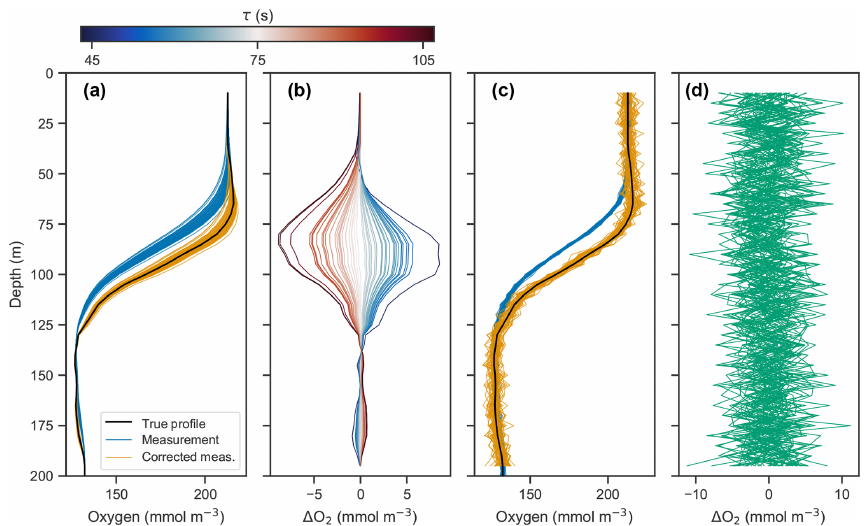
Figure 3. (a) Simulated profile measurements (blue) of the true oxygen profile (black) for 50 different response times drawn randomly from a normal distribution with a standard deviation of 15s and mean of 75s, and corrected measurements using a response time of 75s (orange). (b) Deviations of corrected profiles from the true profile, with line color representing the randomly drawn response time. (c) Simulated measurement and correction of profiles using a response time of 75s, with random noise added from a normal distribution with a standard